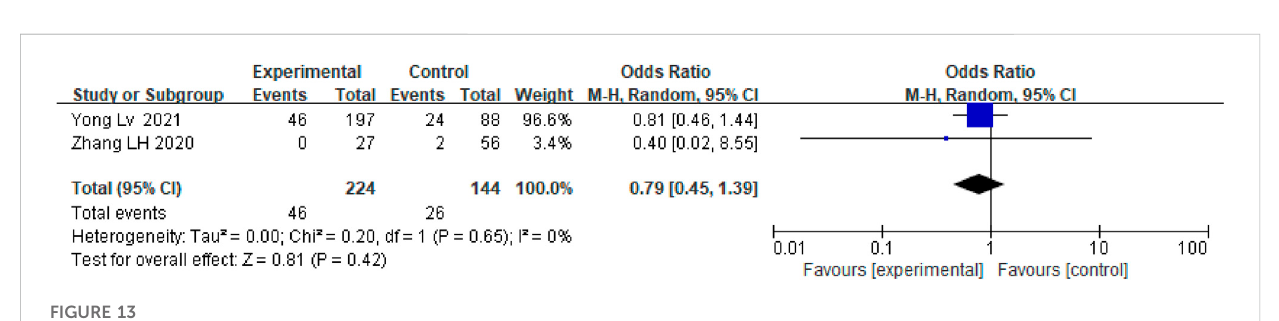
FIGURE 13 Effect of anticoagulation or antiplatelet treatment on 3 years death after TIPS.